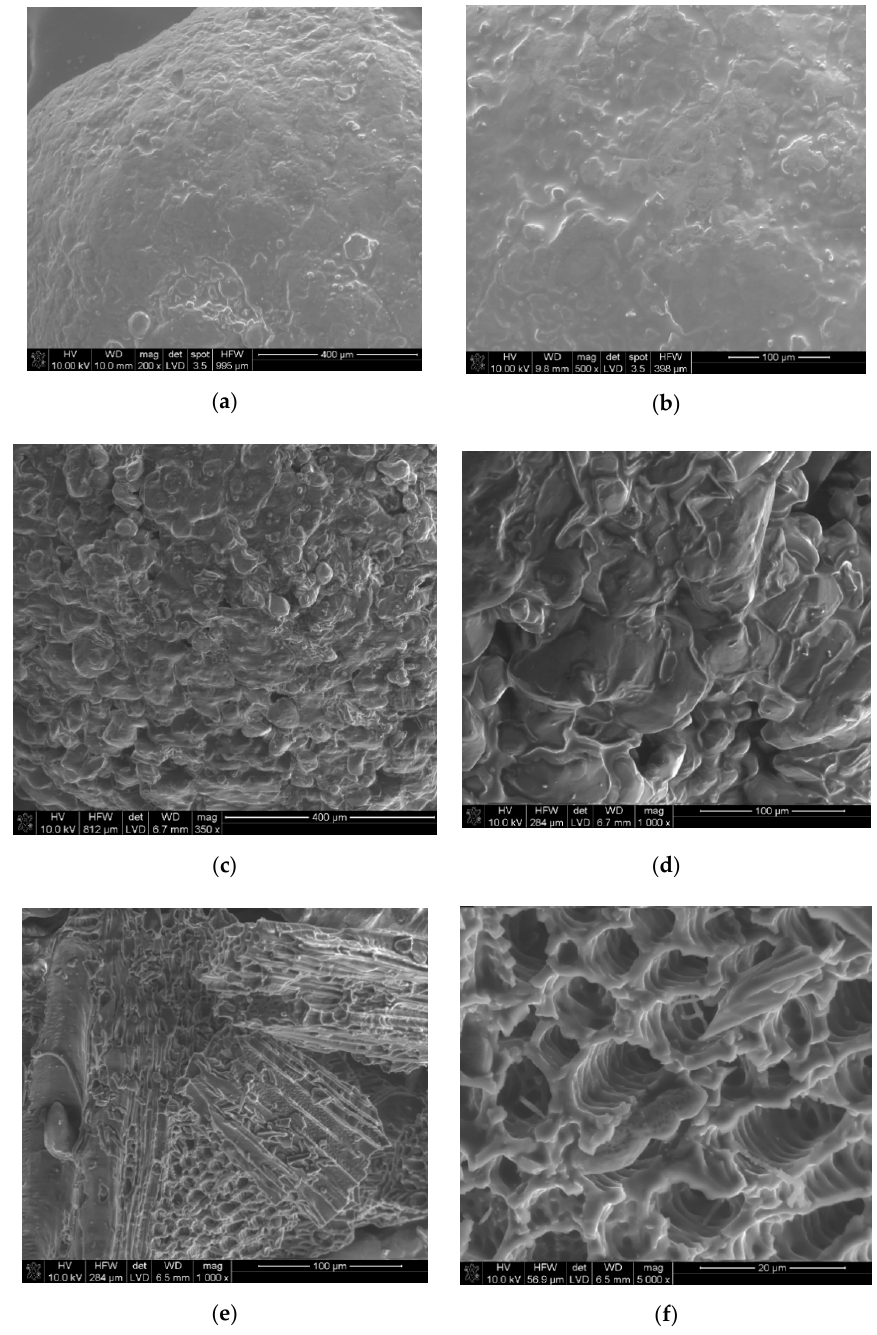
Figure 5. SEM images of ( a ) ANFO at 200× magnification, ( b ) ANFO at 500× magnification, ( c ) non-ideal explosive with 1% of MC at 350× magnification, ( d ) non-ideal explosive with 3% of MC at 1000× magnification, ( e ) MC in non-ideal explosive at 1000× magnification, and ( f ) MC in non-ideal explosive at 5000× magnification.